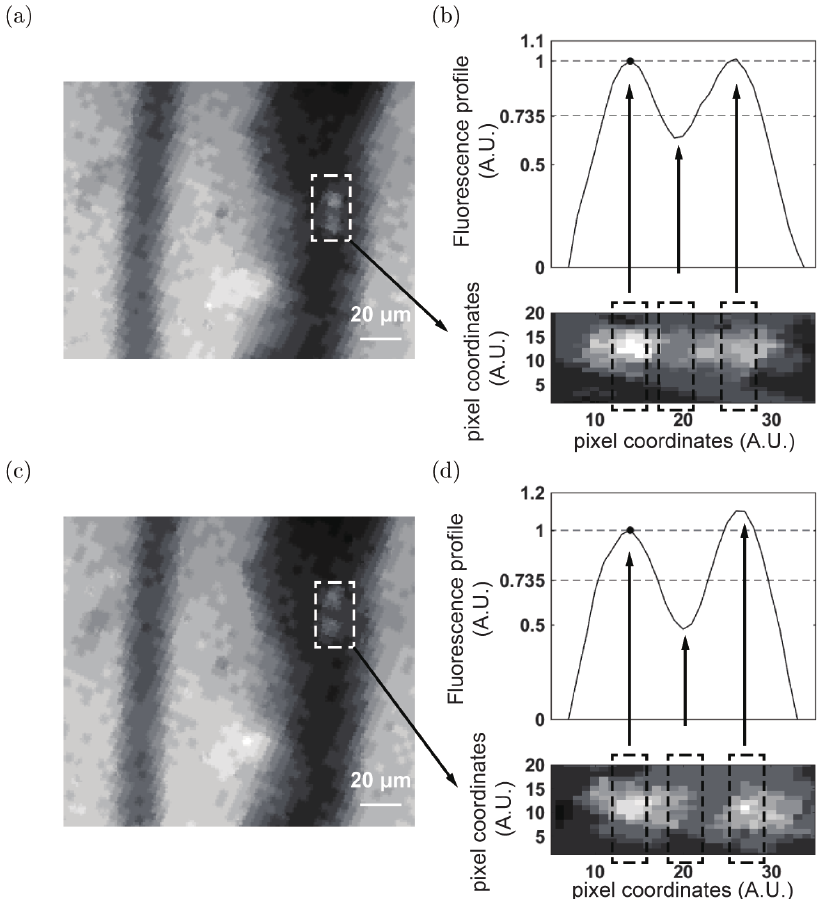
Fig. 5. In vivo validation of proposed algorithm with intravital °uorescence imaging. (a) Typical image of a 4T1 cell cluster with two GFP-labeled cells. (b) Normalized °uorescence pro¯le of the cell cluster in (a). Fluorescence pro¯les were calculated by integrating the °uorescence intensity within the black dotted box, which slid along the horizontal axis. Width of box was (cid:9) 5 (cid:1) m, which was comparable to the laser slit in IVFC. Sliding the box mimicking the movement of a cell °owing through the laser slit. After obtaining the entire pro¯le, it was normalized by the second largest pro¯le value, indicated by a black circle. Normalized valley pro¯le value between two peak pro¯le values was below 0.735, indicating that the °ock of signal represented a dual-cell cluster and complied with the Rayleigh criterion. (c) Image of cell cluster in succeeding frame. (d) Normalized °uorescence pro¯le of cell cluster in (c). A.U. denotes arbitrary